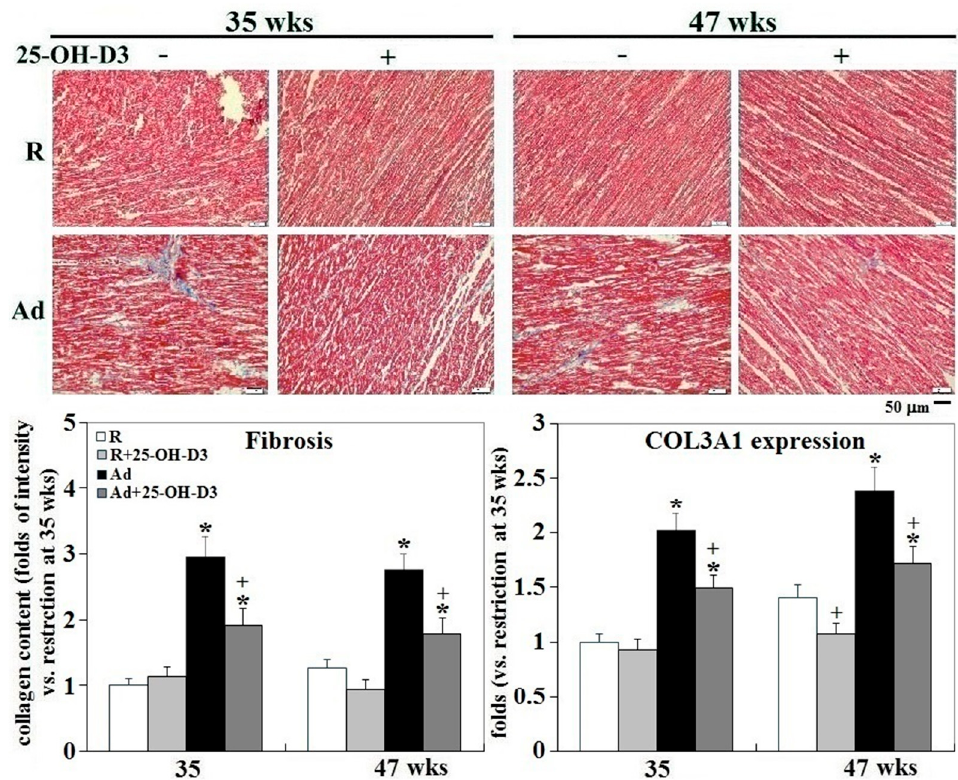
Figure 4. Effects of dietary 25-hydroxycholecalciferol supplementation on cardiac fibrosis of broiler breeder hens provided with restricted or ad libitum feed intake. Three hearts from collections at 35 and 47 wks were used for fibrosis analysis with collagen content by trichrome staining (blue color)( n = 3 for each group) and the remaining four hearts were used for COL3A1 (collagen type 3- 𝛼 1) expression analysis by qRT-PCR method ( n = 4 for each group). Results of qRT-PCR and chromogenic intensity in trichrome staining were expressed ratios relative R-hens at 35 wks.*; significant difference by Ad-feed intake (vs. corresponding R hens, p < 0.05). +; significant difference by 25-OH-D 3 (vs. R or Ad hens, p < 0.05). R; restriction, Ad; ad libitum, 25-OH-D 3 : 25-hydroxycholecalciferol.